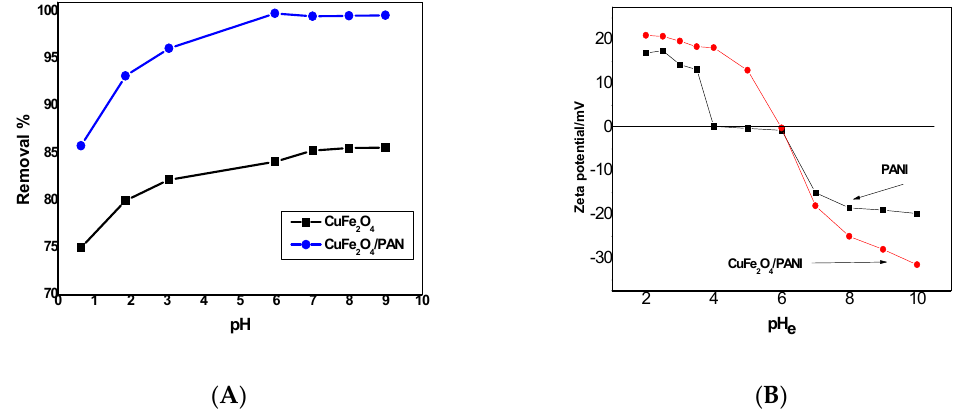
Figure 7. ( A ) Effect of pH on adsorption optimization using CuFe 2 O 4 and CuFe 2 O 4 /PANI nano- composite sorbents (V= 30 mL, Hg 2+ concentration= 25 µg/mL, adsorbent amount = 0.1 g CuFe 2 O 4 and 0.2 g CuFe 2 O 4 /PANI and contact time = 2 h for CuFe 2 O 4 and 1 h for CuFe 2 O 4 /PANI). ( B ) Plots of the zeta potential as a function of pH for CuFe 2 O 4 /PANI and